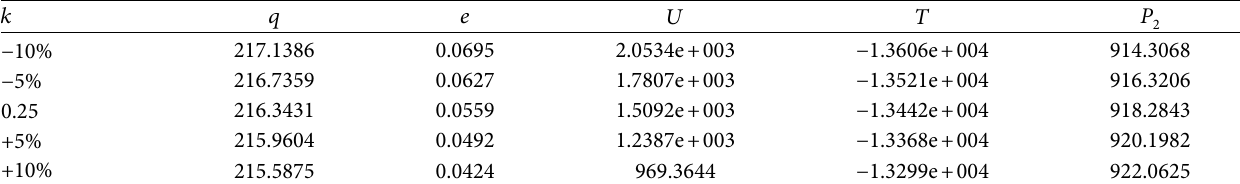
Table 3: Sensitivity analysis for the coefficient of cost increase for carbon capture 𝑘 .